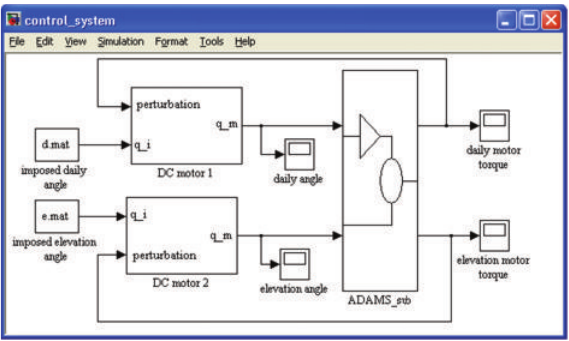
Figure 7: The block diagram of the control